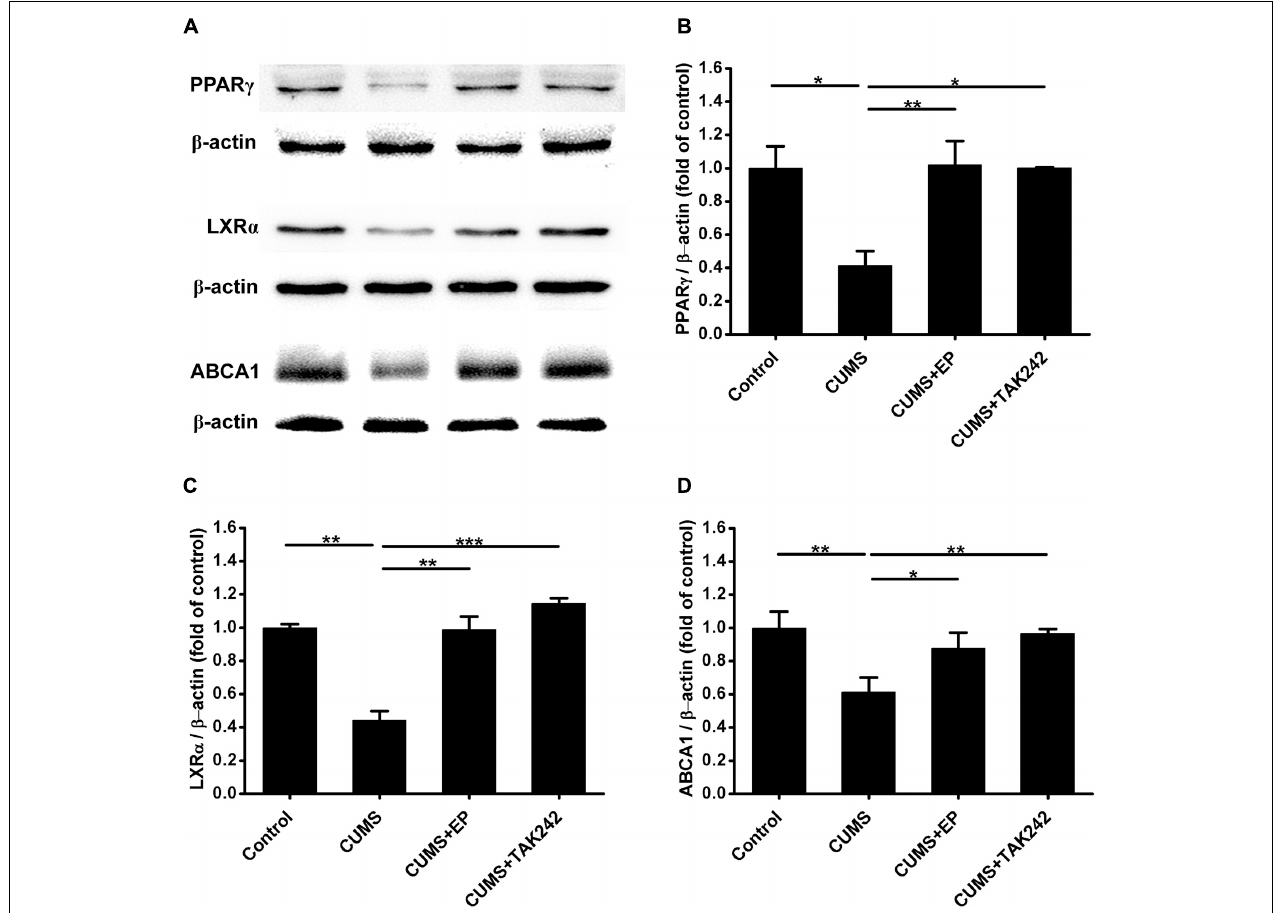
FIGURE 6 | Effect of EP and TAK-242 treatment on the expressions PPAR γ , LXR α , and ABCA1 protein levels in aorta of CUMS ApoE − / − mice. Over a 16-week period treatment, entire aorta from the aortic root to the iliac bifurcation was harvested for Western blot analysis. (A) Representative Western blots of PPAR γ (57 kDa), LXR α (50 kDa), and ABCA1 (254 kDa). (B–D) Quantification of PPAR γ , LXR α , and ABCA1 protein levels by the NIH Image J software revealed drown-regulation of PPAR γ , LXR α , and ABCA1 proteins in aorta of CUMS ApoE − / − mice, whereas HMGB1 inhibition by EP or TLR4 inhibition by TAK-242 significantly reversed CUMS-induced the down-regulation of these three proteins in aorta. Data were expressed as mean ± SEM ( n = 5). Statistical analysis was performed by Student’s t -test or one-way analysis of variance. ∗ P < 0.05, ∗∗ P < 0.01, ∗∗∗ P <